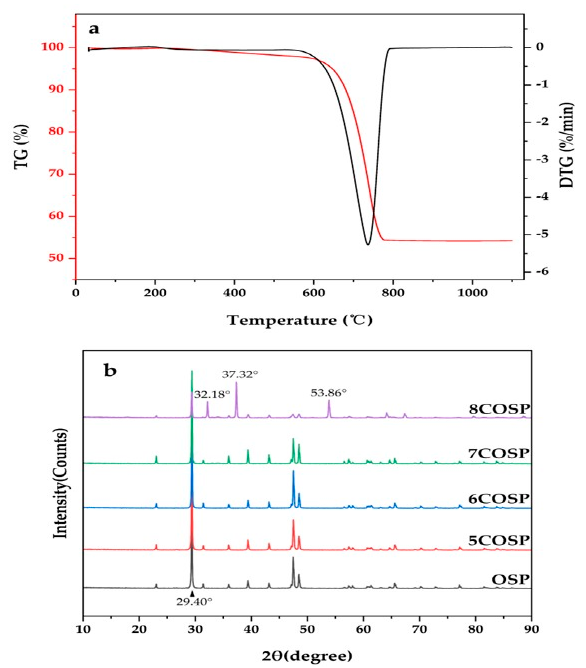
Figure 3. TG-DTA curves of the OSP and XRD patterns of pre- and post-calcined OSP. ( a ): TG-DTA curves of OSP; ( b ): XRD patterns of pre- and post-calcined OSP.